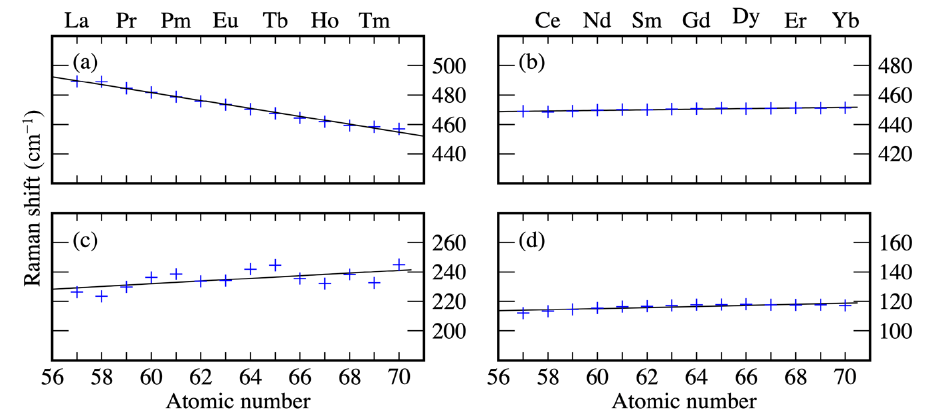
Figure 6. Raman shifts of selected surface localized modes of RESi 2 -Silicide monolayers with (1 × 1)-periodicity as a function of the rare earth calculated within DFT-PBEsol. Modes in ( a , c ) are a lateral and a vertical shearing of the Si 1 -Si 2 bilayer, respectively. Modes in ( b , d ) are vertical displacement of the Si atoms below the silicide monolayer and a lateral displacement of the substrate top bilayer,